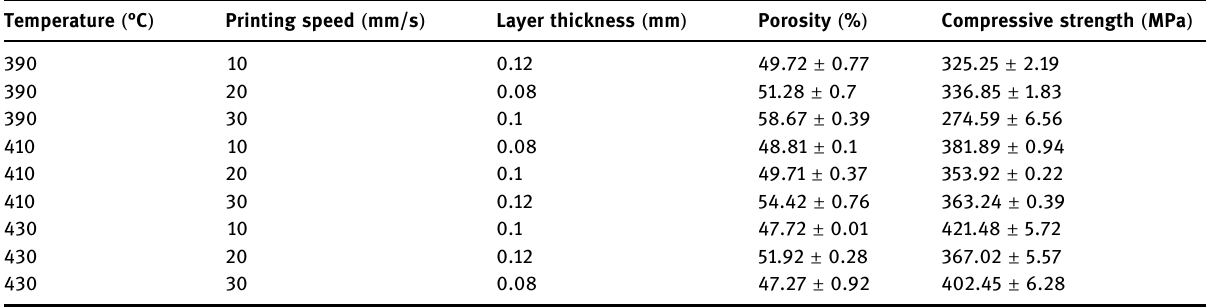
Table 3: The results of Taguchi experiment